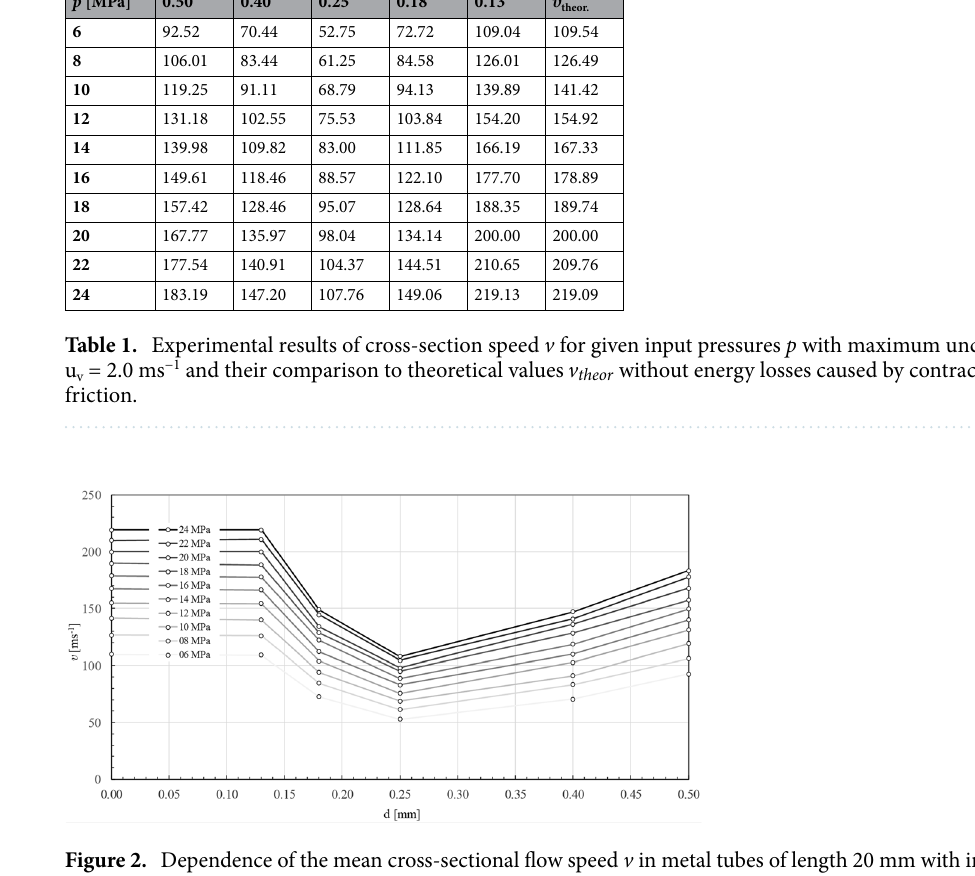
Figure 2. Dependence of the mean cross-sectional flow speed v in metal tubes of length 20 mm with internal diameter d for input pressure p = (6, 8, 10, 12, 14, 16, 18, 20, 22, 24) MPa from values in Table